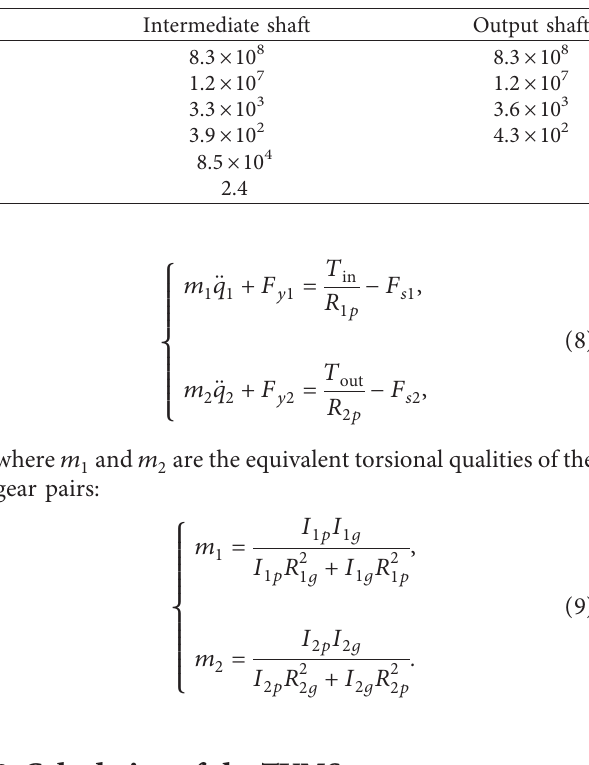
Figure 3: Dynamics model of the helical gear transmission Table 2: Equivalent stiffness and damping.